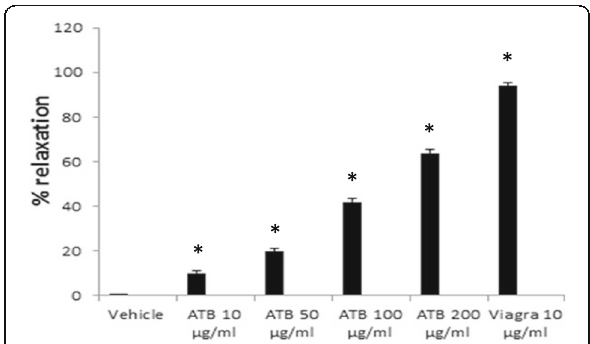
Fig. 1 Effect of ATB and Viagra on isolated rat corpus cavernosum smooth muscle (CCSM). Data are expressed as mean ± SD ( n = 6), one-way ANOVA followed by Tukey test Post hoc analysis. * P < 0.05 as compared to control